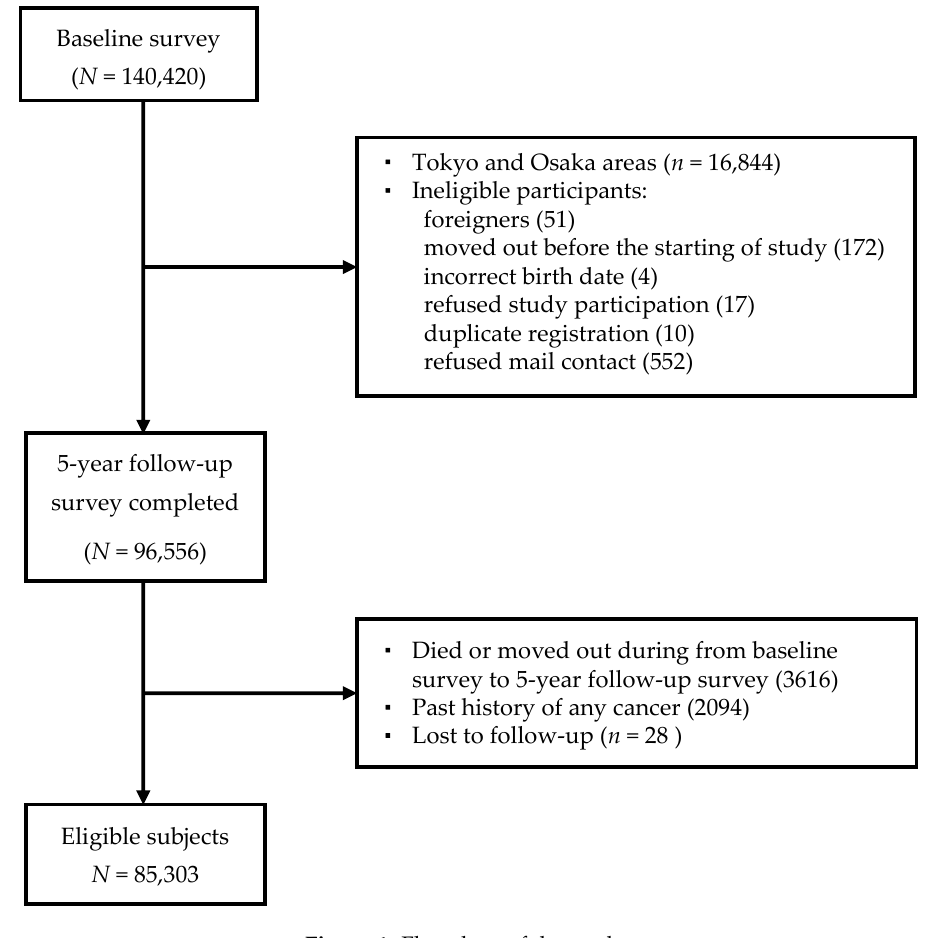
Figure 1. Flowchart of the study.